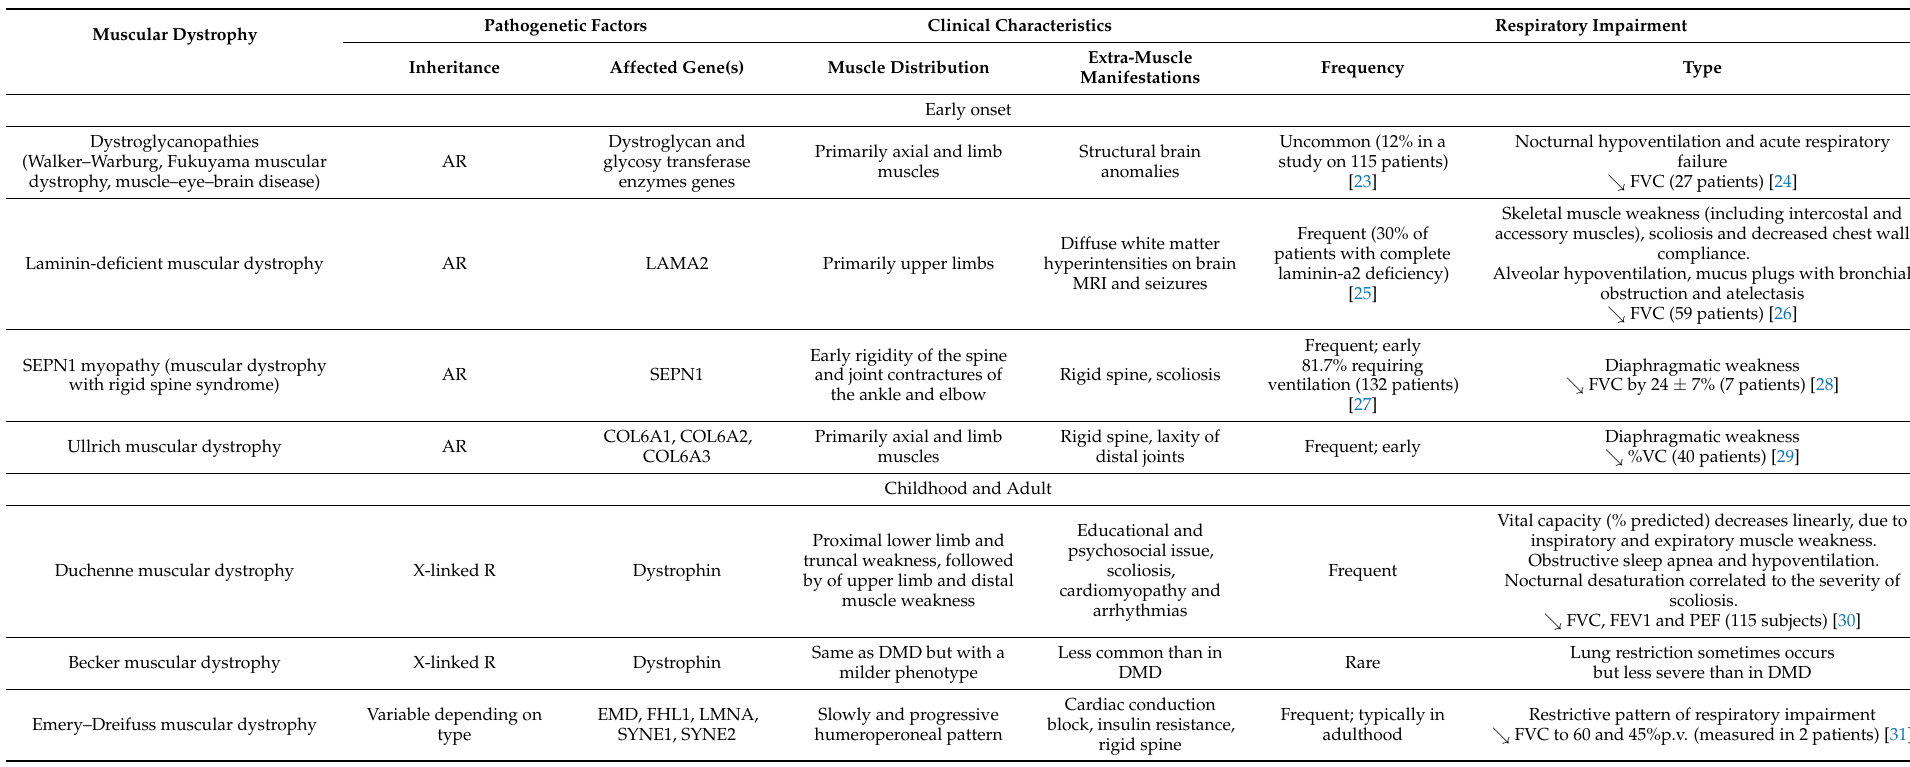
Table 2. Overview of respiratory involvement in muscular dystrophies. AD: autosomal dominant; AR: autosomal recessive; FVC: forced vital capacity; MEP: maximum expiratory